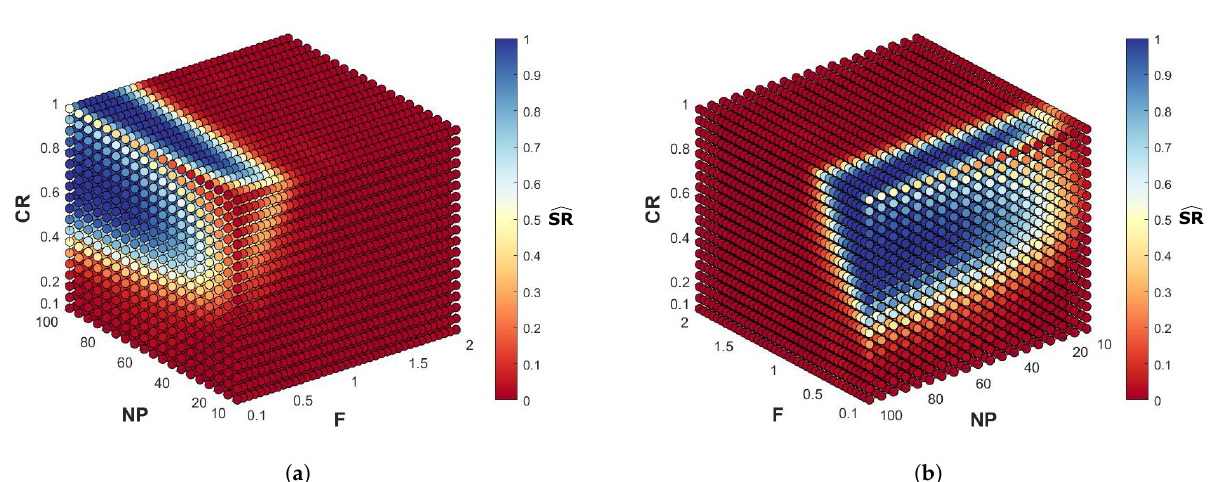
Figure 5. The illustration of 14,709 parameter combinations of Fcn2. Each point reflects a combination of NP, F and CR. The point color depends on (cid:99) SR precision value. The dark blue color means a high DE precision to achieve the requirements. The dark red color means a small DE precision to achieve the requirements: ( a ) first perspective, ( b ) second perspective.